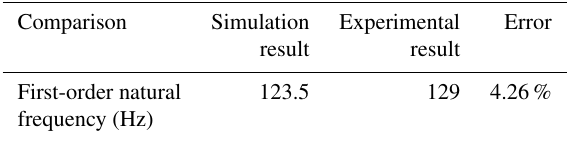
Table 3. Comparison between simulation results and experimental results.